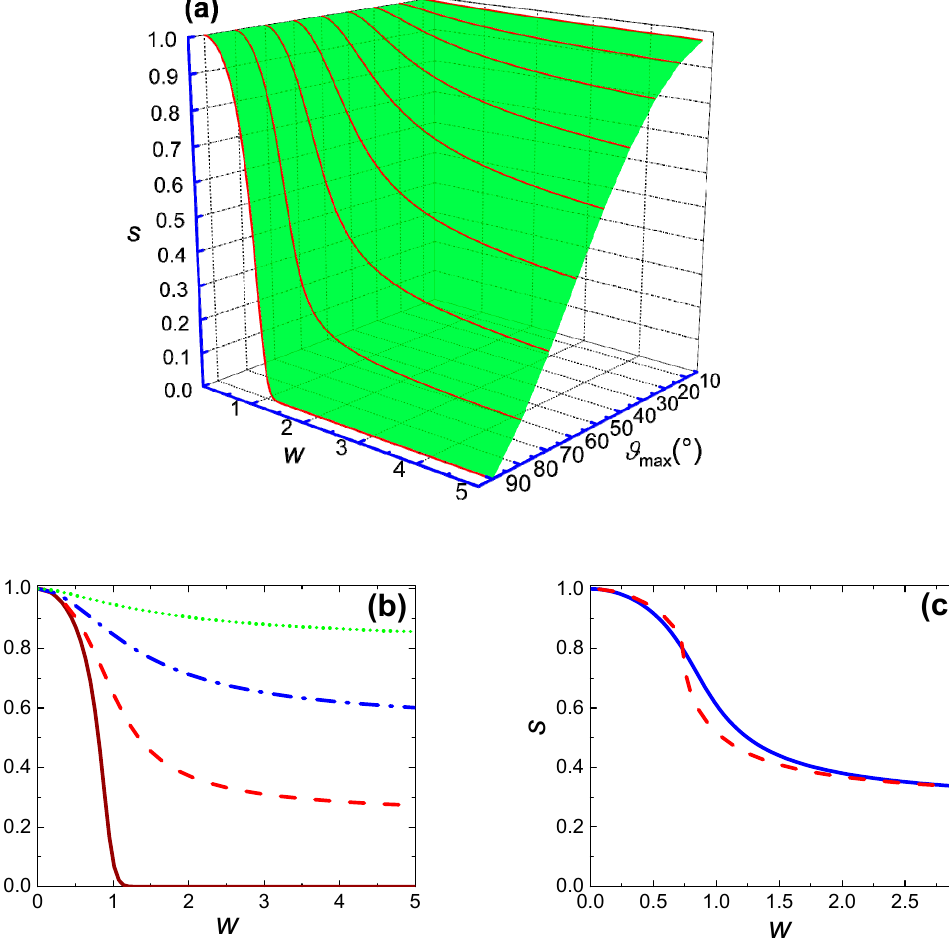
Figure 3. ( a ) Order parameter S variation as a function of w and ϑ max . ( b ) S ( w ) variation for several values of ϑ max ; full line: ϑ max = π /2, dashed line: ϑ max = 7 π /18, dash-dotted line: ϑ max = π /3, dotted line: ϑ max = 2 π /9. ( c ) Comparison of S ( w ) dependences for a step-like (full line) and the Gaussian probability distribution (dashed line). The step-like distribution is described by (cid:16) (cid:17) (cid:16) (cid:17) = P = 0, where P P ϑ ≤ ϑ ( max ) ϑ > ϑ ( max ) 0 and P 0 is a constant, and the Gaussian distribution is described by P = P G ( ϑ ) = Ce − ϑ 2 /2 σ 2 , where C is the normalization constant, and σ is the standard deviation. Both probability distributions must be normalized on the interval from ϑ = 0 to ϑ = π . We chose the free parameters for both distributions in such a way to roughly match the observed drop in experimentally measured 𝑆(𝑝) dependence. For the step-like distribution, we obtain 𝜗 (cid:3040)(cid:3028)(cid:3051) = 0.387 𝜋 , while for the Gaussian distribution, 𝜎 = 0.798 and 𝐶 = 0.25.